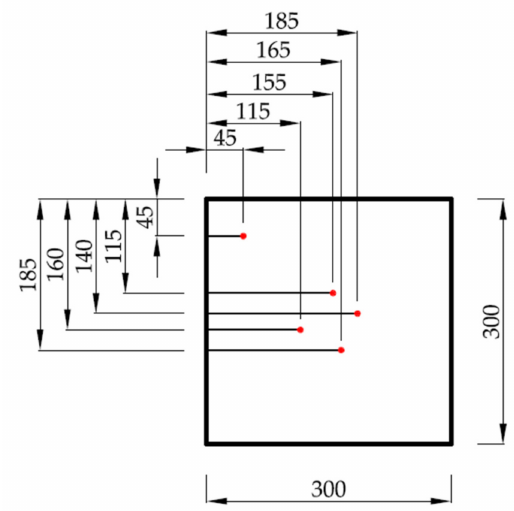
Figure 4. The distribution thermocouple rows on temperature measurement plate (dimensions are shown in millimeters). The red dots indicate the temperature measurement points.